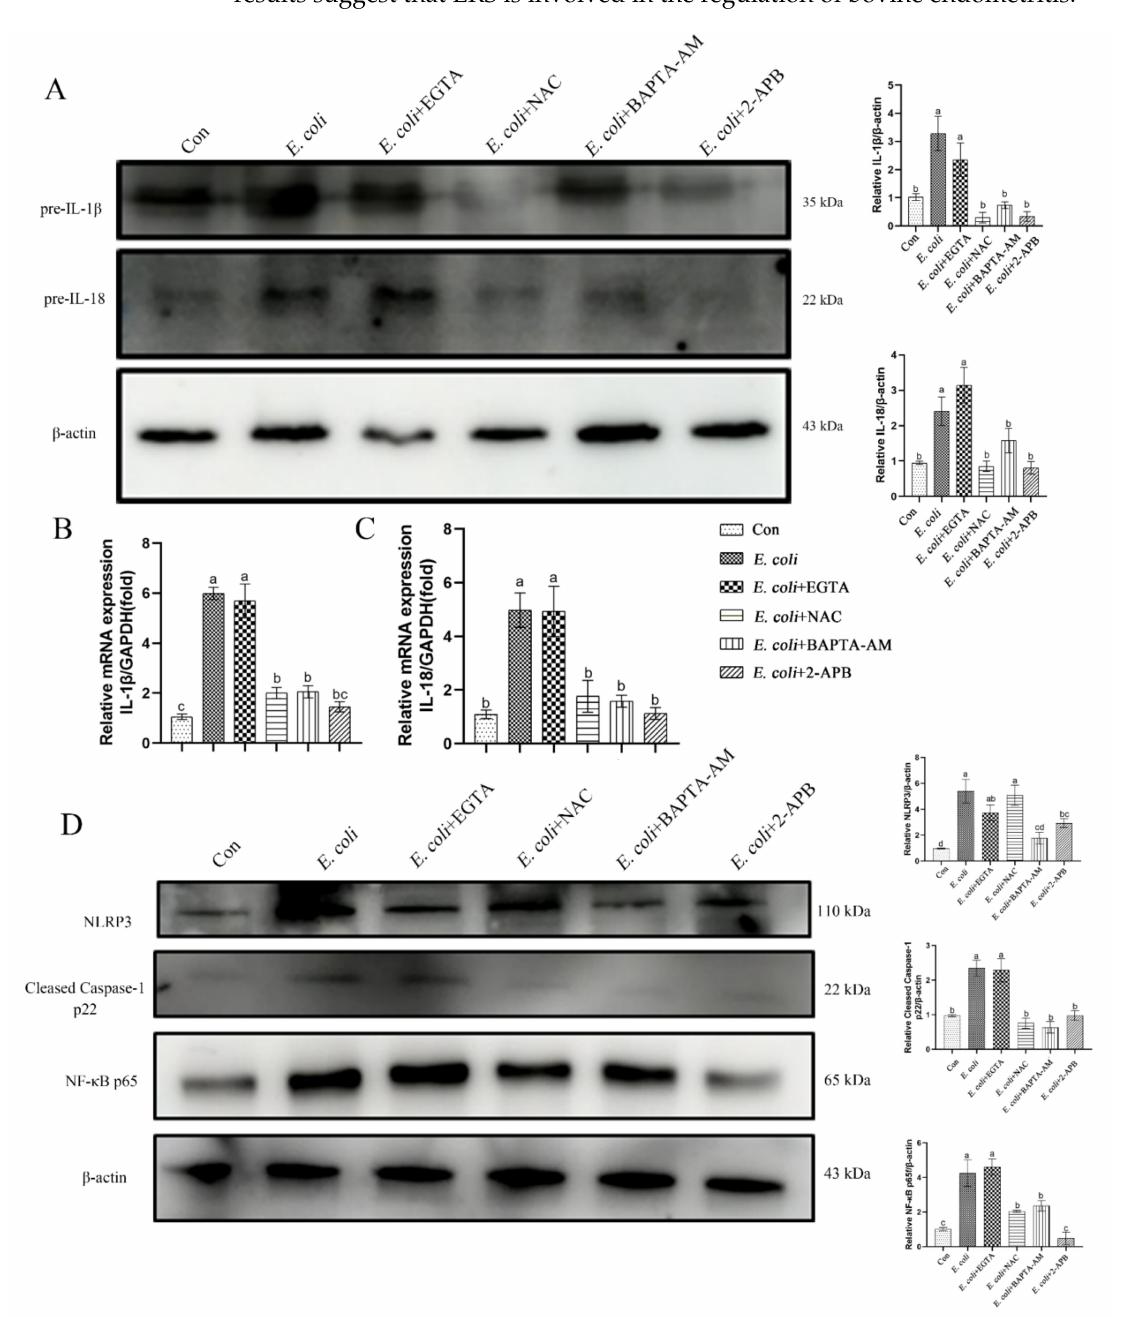
Figure 5. The inflammatory response induced by E. coli infection requires ROS production and release of Ca 2+ . Primary bEECs were pre-treated with EGTA (5 mM), NAC (8 mM), BAPTA-AM (10 µ M), or 2-APB (50 µ M) before E. coli infection for 6 h. ( A ) Immunoblotting analysis of IL-1 β and pre-IL-18 cytokine proteins. ( B ) Real-time quantitative PCR of the expression of IL-1 β . ( C ) IL-18 was detected by real-time quantitative PCR. ( D ) Protein levels of NLPR3, cleaved Caspase-1, and NF- κ B p65 were analyzed by immunoblotting. Con, no infection control. The data are means ± SEM of three independent experiments. Bars with different letters indicate significant differences ( p <